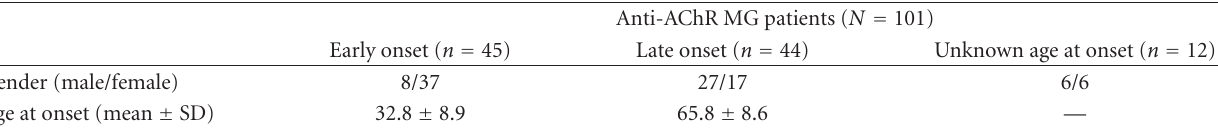
Table 1: Characteristics of the MG study